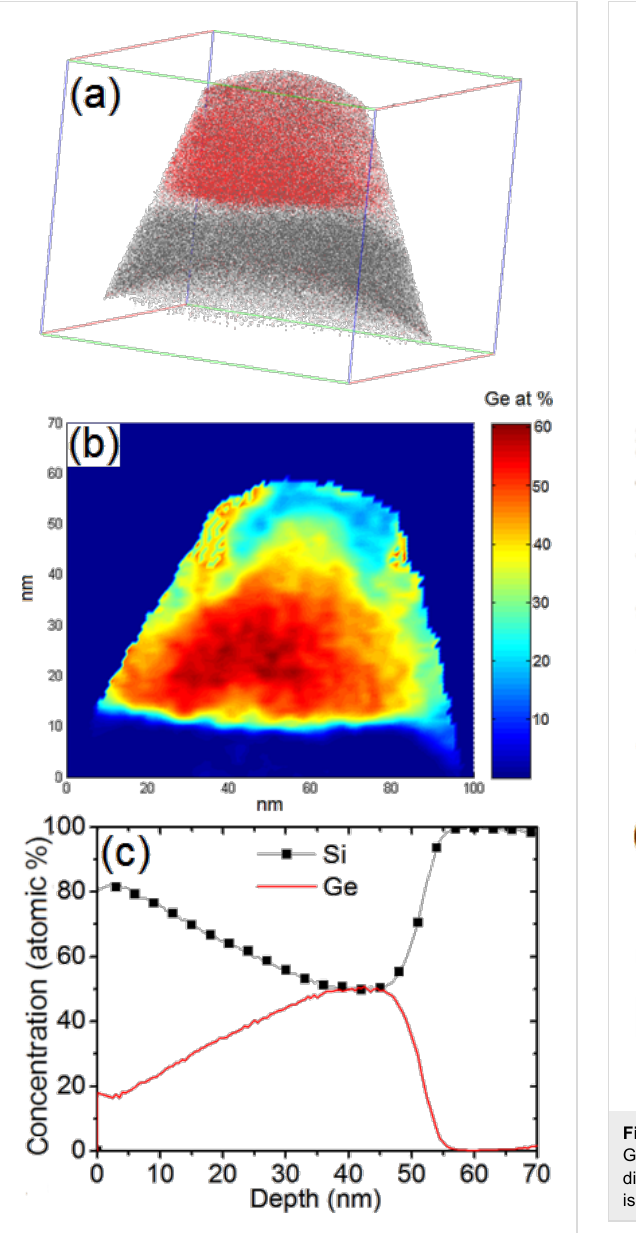
Figure 8: APT analysis: (a) 3D volume (120 × 120 × 100 nm 3 ), (b) 2D map of the Ge concentration distribution in the center of the volume presented in Figure 8a, and (c) top-down 1D Si and Ge concentration profiles measured in the volume presented in Figure 8a.